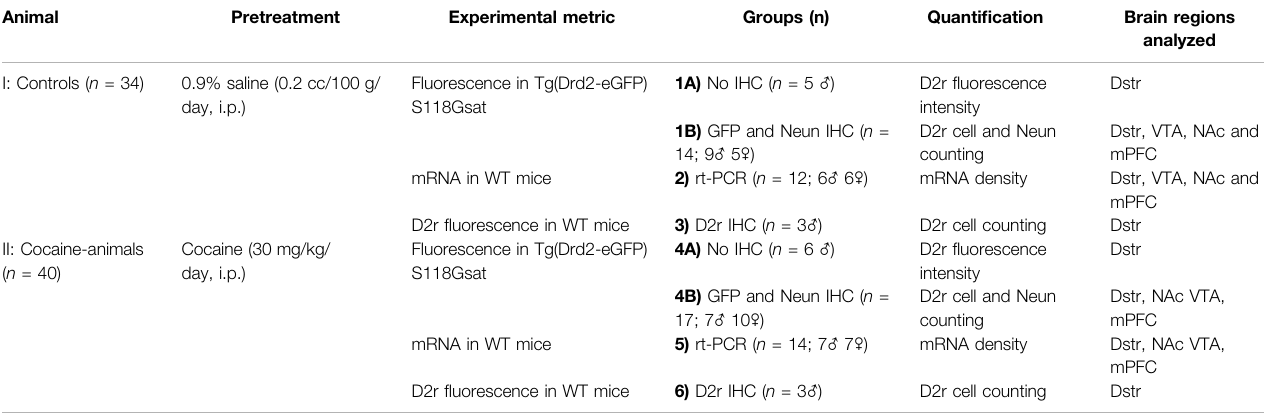
TABLE 1 | Experimental Design: Animals, Pretreatment, Experimental approaches. Animal Pretreatment Experimental metric Groups (n) Brain regions